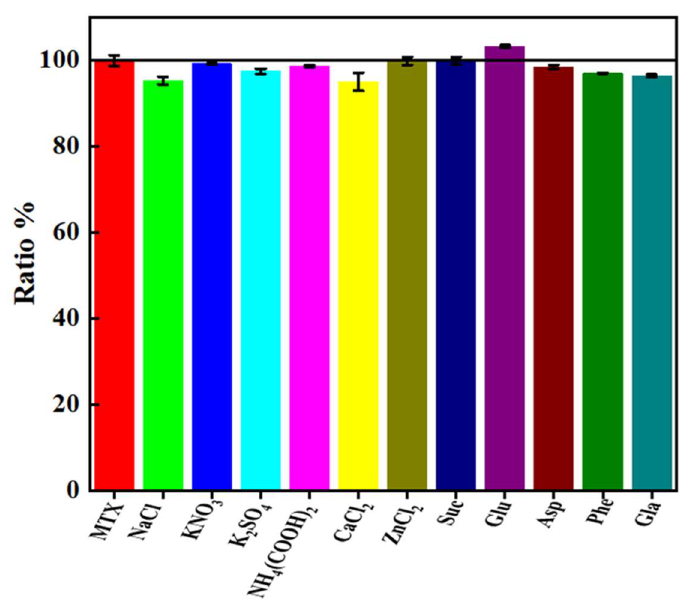
Figure 6. Influence of some metal ions and important biological substances on the 50 μM MTX.